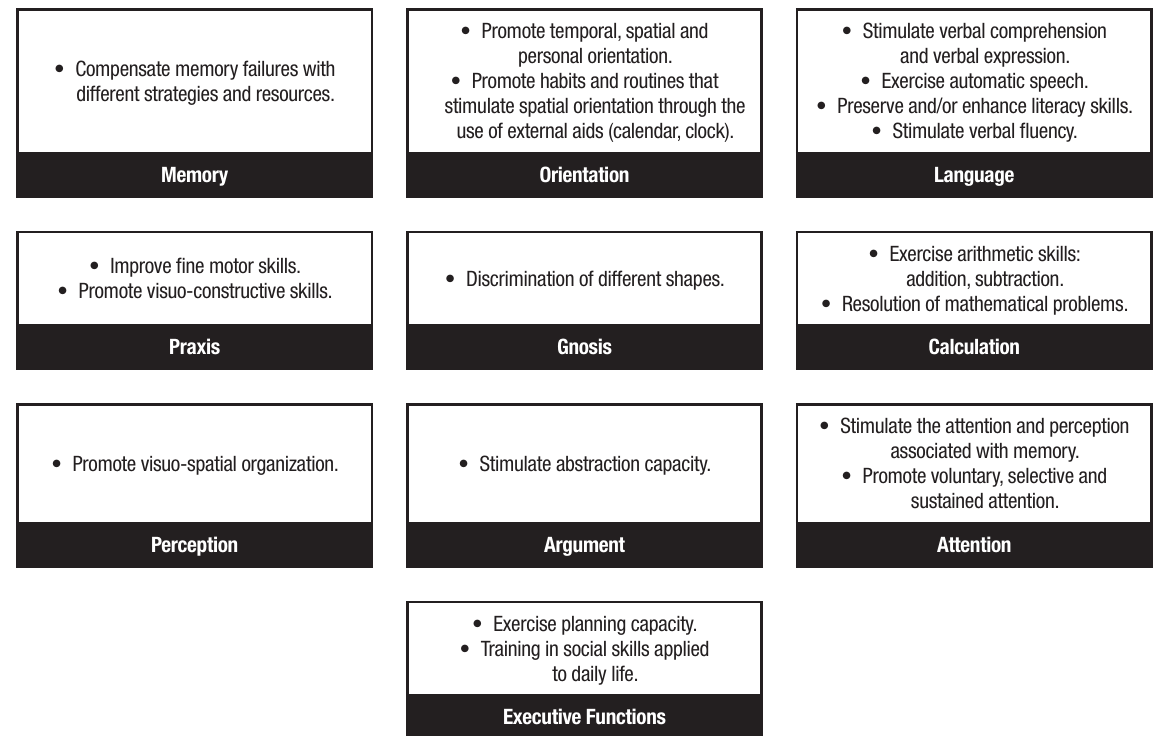
Figure 2. Development objectives following the red mental activation notebook guidelines.